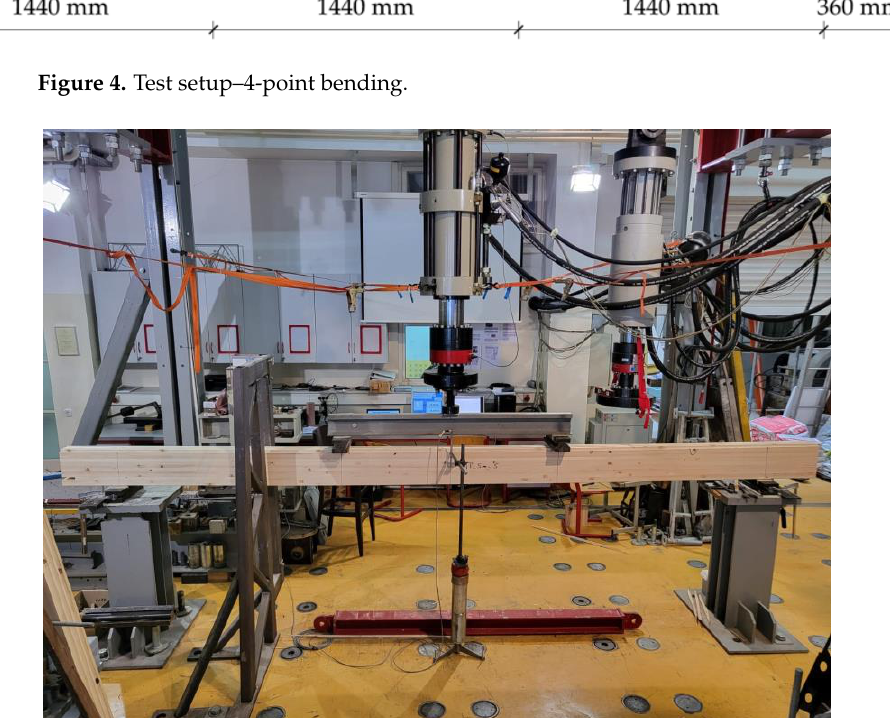
Figure 5. Experimental work — 4-point bending at ambient temperature.